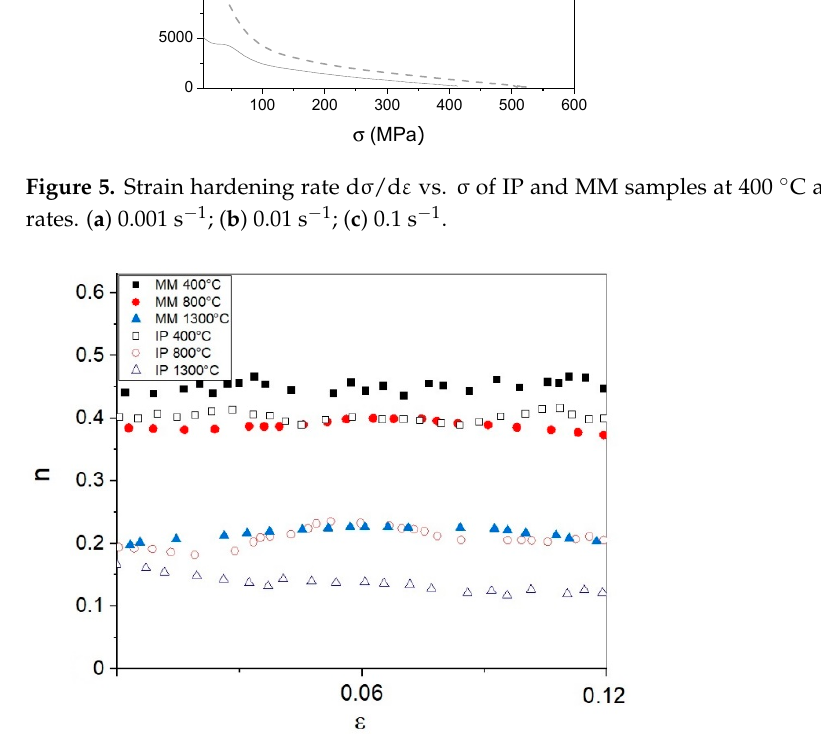
Figure 6. Strain hardening exponent n of IP and MM samples deformed at the lowest strain rate (0.001 s − 1 ).